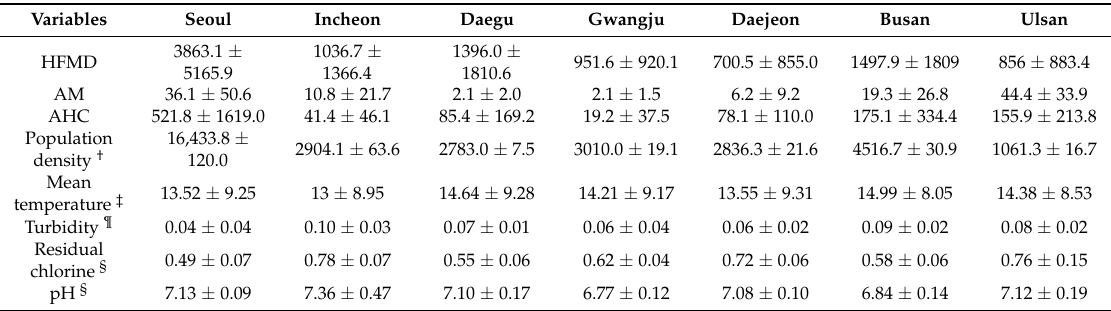
Table 2. Descriptive statistics of the seven metropolitan provinces in Korea, 2010–2015 (mean ± standard